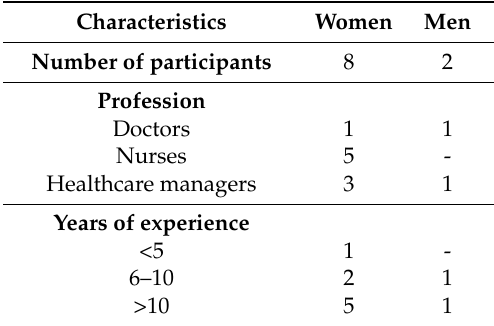
Table 2. Characteristics of healthcare